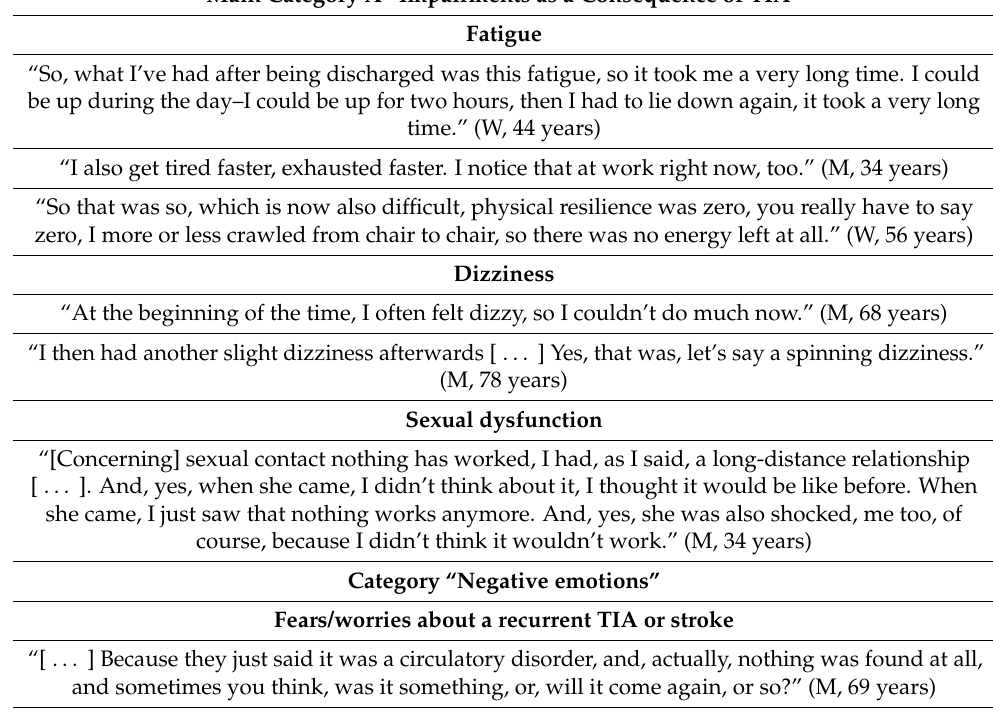
Table A1. Cont. Main Category A “Impairments as a Consequence of